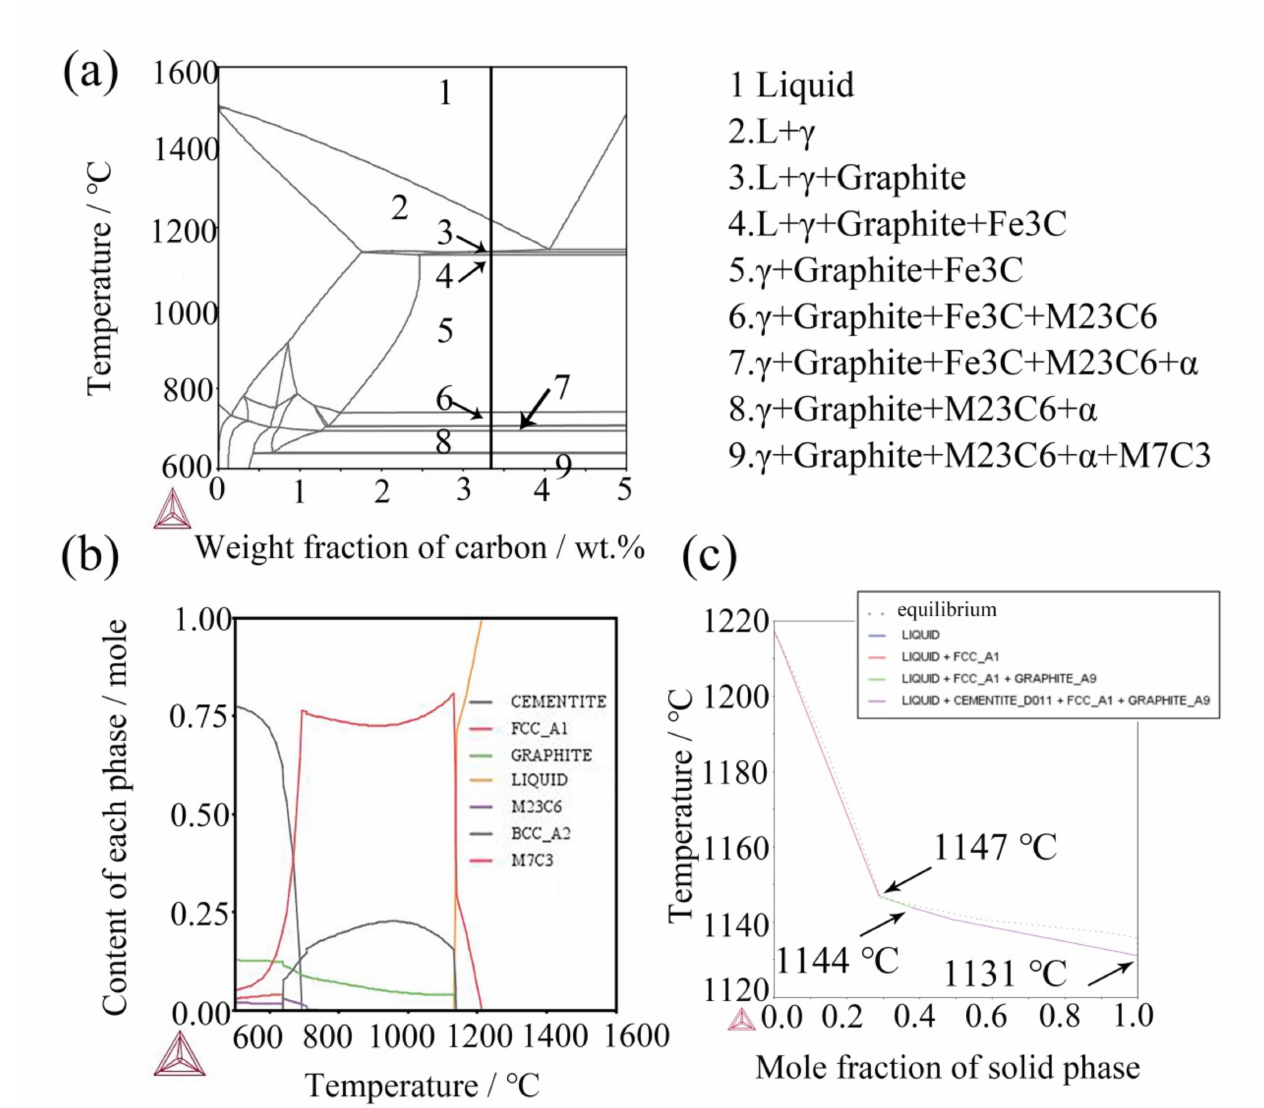
Figure 7. ( a ) Equilibrium phase diagram of ICCI: L-liquid, γ -austenite; ( b ) content of each phase fraction of ICCI; ( c ) non-equilibrium mole fraction of solid